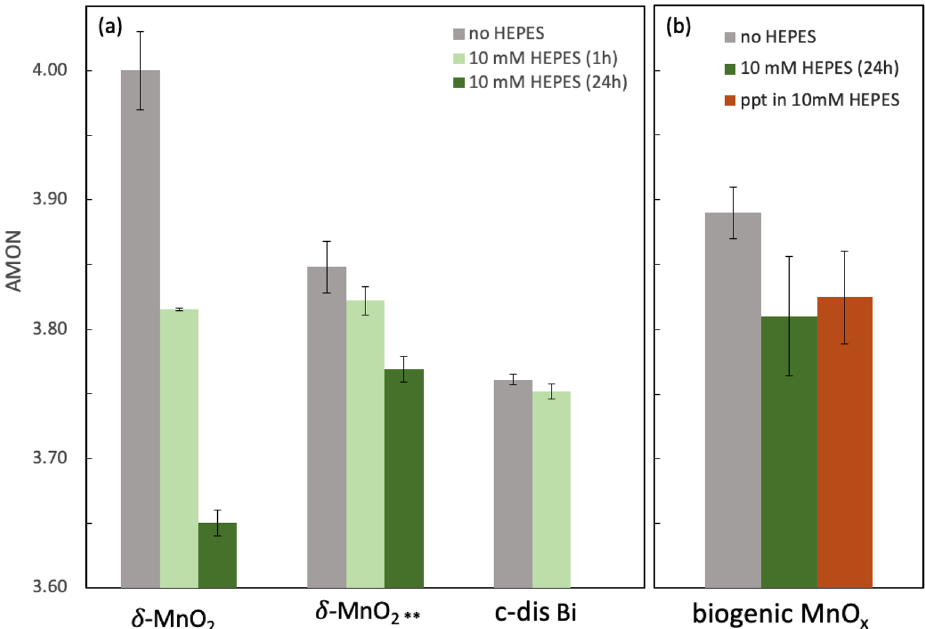
Figure 4. ( a ) Average manganese oxidation number (AMON) for δ-MnO 2 , δ-MnO 2 ** [15% Mn(III)] and c-dis Bi [16% Mn(III), 4% Mn(II)] before and after reaction with 10 mM HEPES at pH 7.5 and a 10:1 HEPES:Mn ratio. For δ-MnO 2 **, AMON values are estimated from PP-Mn(III) measurements. ( b ) AMON values for biogenic Mn oxides precipitated in the presence and absence of HEPES at pH 6.8 with a 40:1 HEPES:Mn ratio. Biogenic Mn oxides precipitated in the absence of HEPES (grey bar) were subsequently reacted with 10 mM HEPES (t = 24 ± 4 h) (green bar) and compared with biogenic oxides precipitated in the presence of 10 mM HEPES (brown bar). Error bars represent standard deviation of